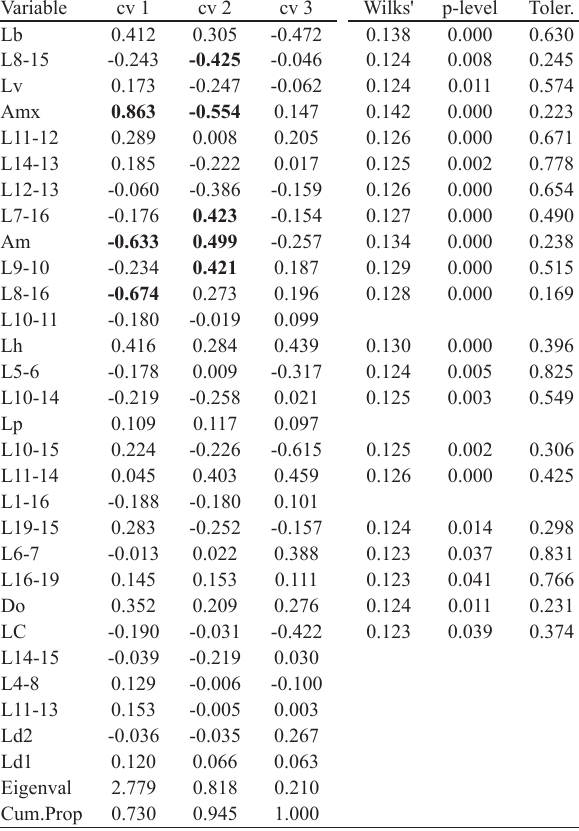
Tab. 2. Standardized coefficients of canonical variables